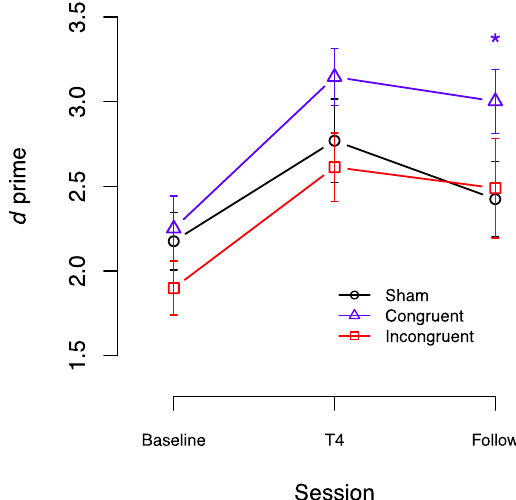
Figure 3. At baseline, T4, and T5, performance (d ′ ) on the 3-back near-transfer task was measured without concurrent tDCS to test the transfer of tDCS-enhanced adaptive n-back training gains. Error-bars represent the standard error (SEM). * Indicates significant t-tests (p < 0.05).